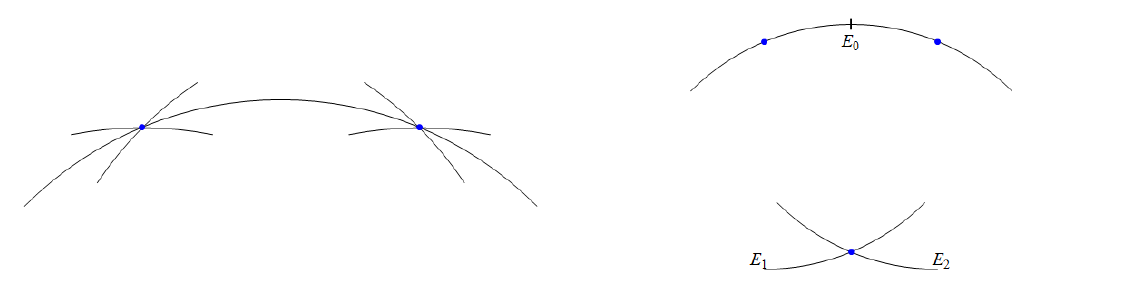
Figure 2: The operation on arcs (left) and the first step of the construction